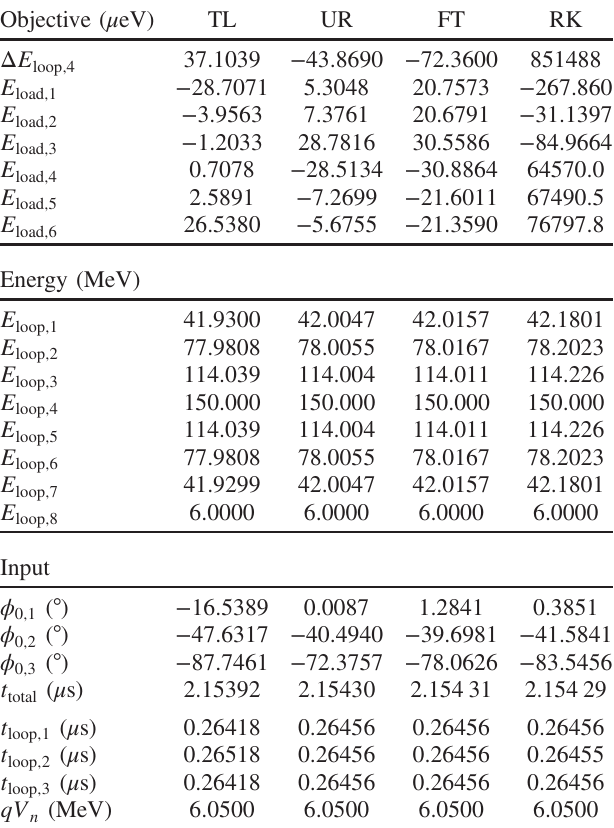
TABLE II. Peak loop energy and cavity load objectives after optimization, resulting beam energy during each loop, and the associated best input settings (phase, total time, loop time of flights, and cavity voltage) after numerical optimization of ϕ 0 and t total